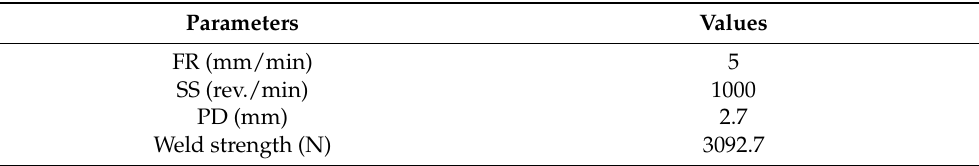
Table 5. Optimum values of FSSW